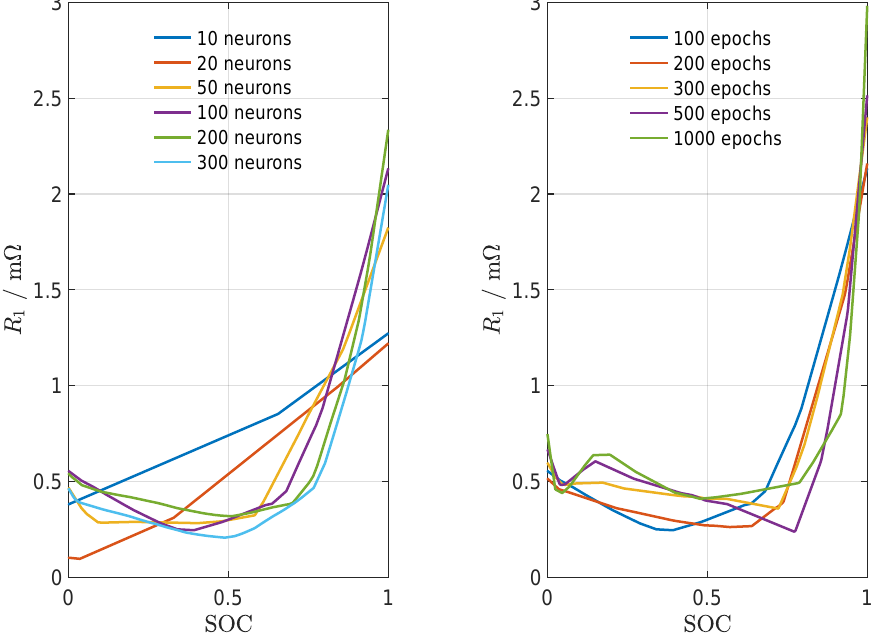
Figure 4. Simulation results: approximation results for R 1 for i bat = − 50A derived from evaluation of function f ∗ ; ( left ): results for a varying number of hidden neurons in f ∗ and 100 training epochs in the first training part; ( right ): results for 100 hidden neurons in f ∗ and a varying number of training epochs in the first training